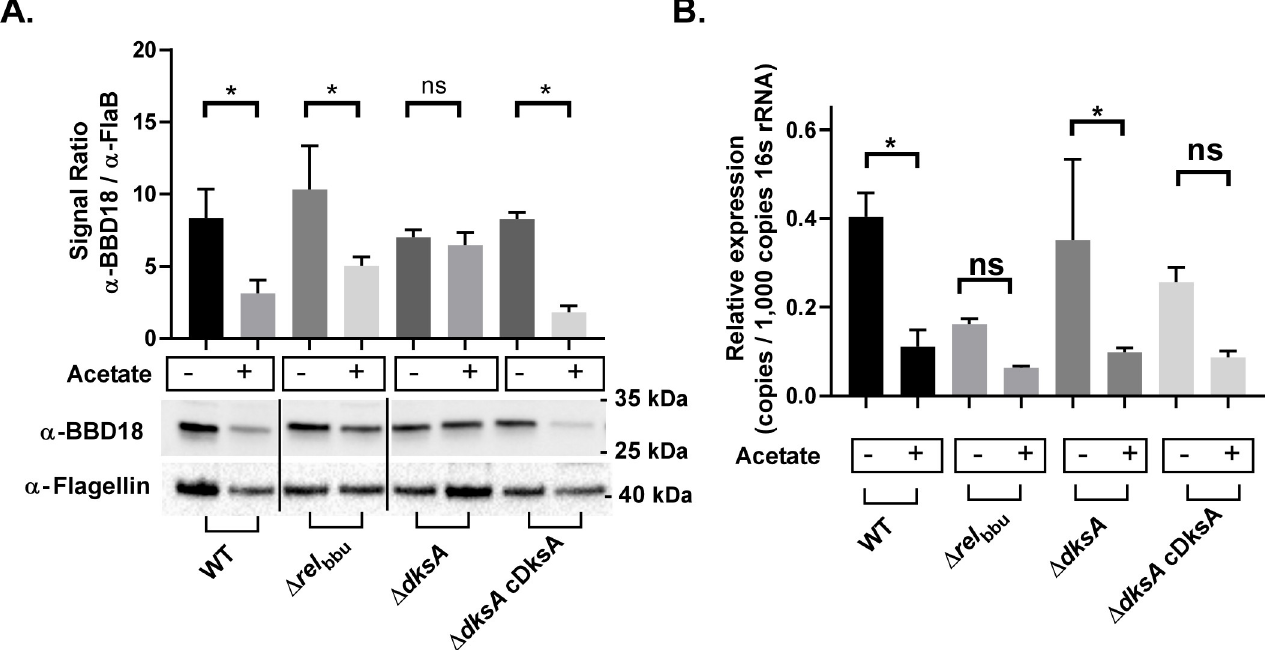
Fig 6. Relative expression of bbd18 /BBD18 by B . burgdorferi in response to growth in BSKII pH 7.6 and BSKII pH 6.7 + 20mM acetate. Whole cell lysates and RNA were collected from 297 wild-type (WT), Δ rel bbu , Δ dksA , and chromosomally complemented Δ dksA ( Δ dksA cDksA) B . burgdorferi strains cultured to 5 x 10 7 spirochetes / mL density in either BSKII-pH 7.6 (acetate -) or BSKII-pH 6.7 with 20 mM acetate (acetate +). Expression of BBD18 protein levels (A) were determined by densitometry of chemiluminescence signals and signals were normalized to expression of FlaB. RNA expression levels of bbd18 (B) were determined by RT-qPCR and were normalized to 16s rRNA expression level. Data are representative of 3 replicate experiments. Asterisk indicate adjusted p - values < 0.05 in a Sidak multiple comparisons test.